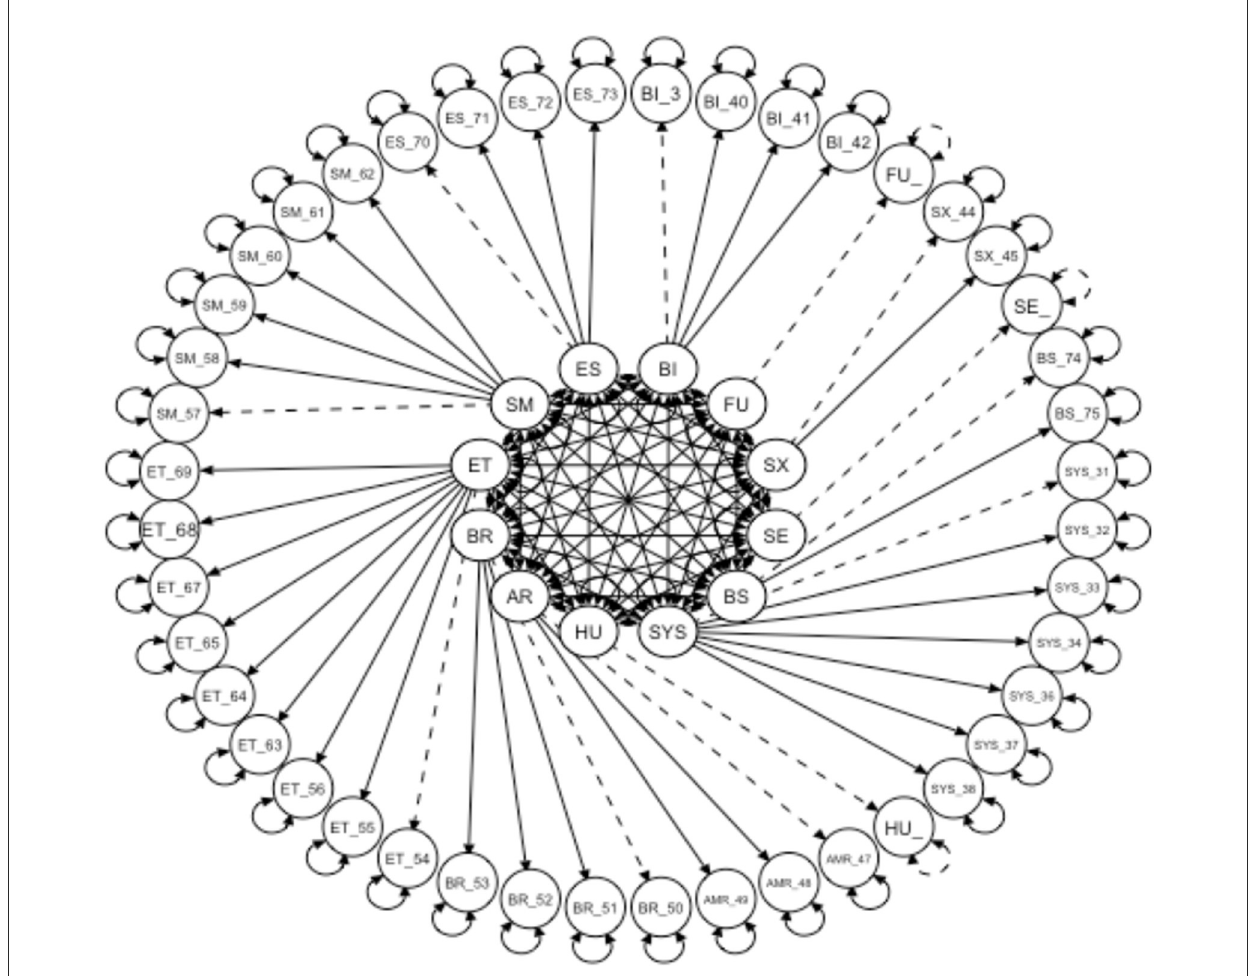
FIGURE2 Confirmatory factor analysis model of the Indonesian EORTC BR-45